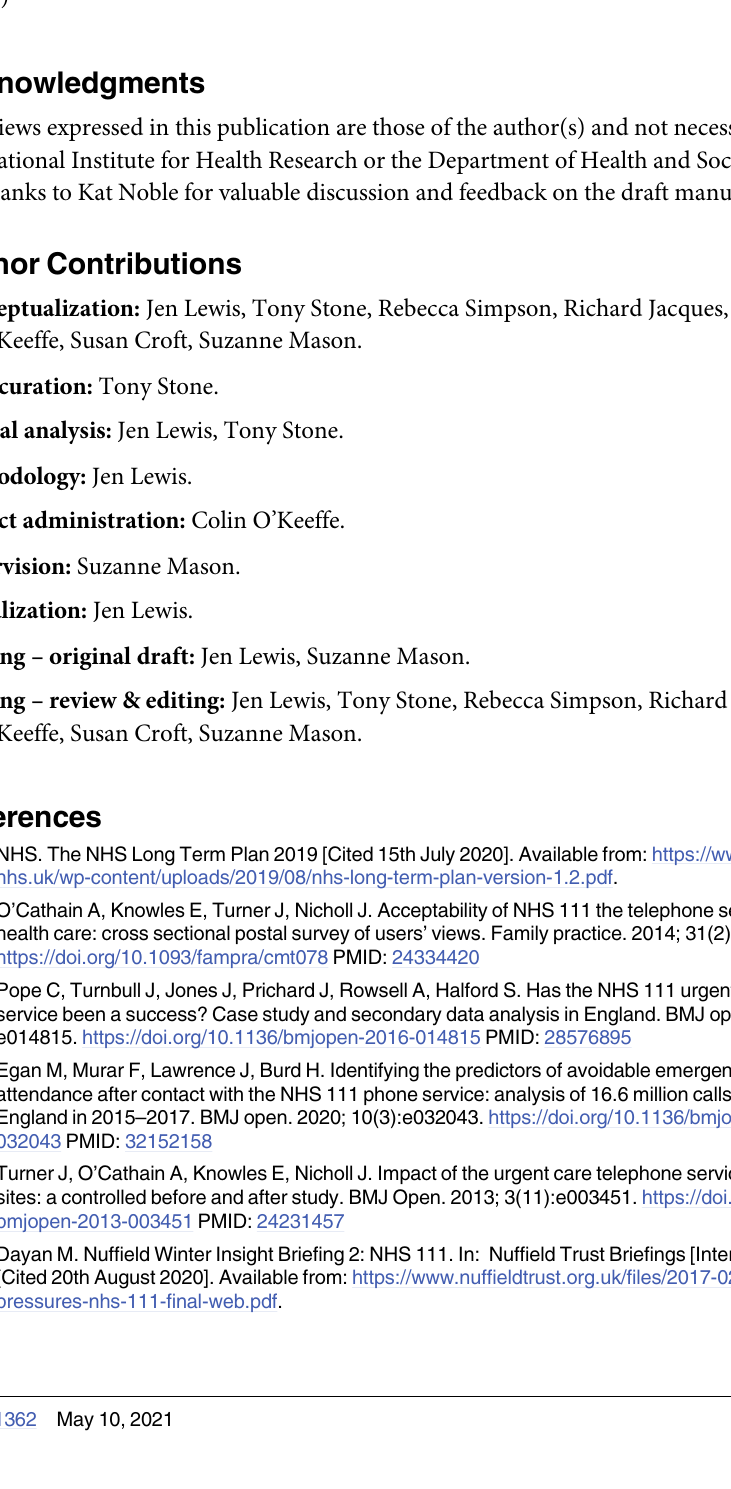
line = ambulance dispatched; dashed line = directed to primary care; dot-dash line = advised to self-care). S2 Fig. Distribution of time taken to attend ED for patients across different age brackets. S3 Fig. Distribution of hours taken to attend ED for patients advised by a call handler with or without clinical